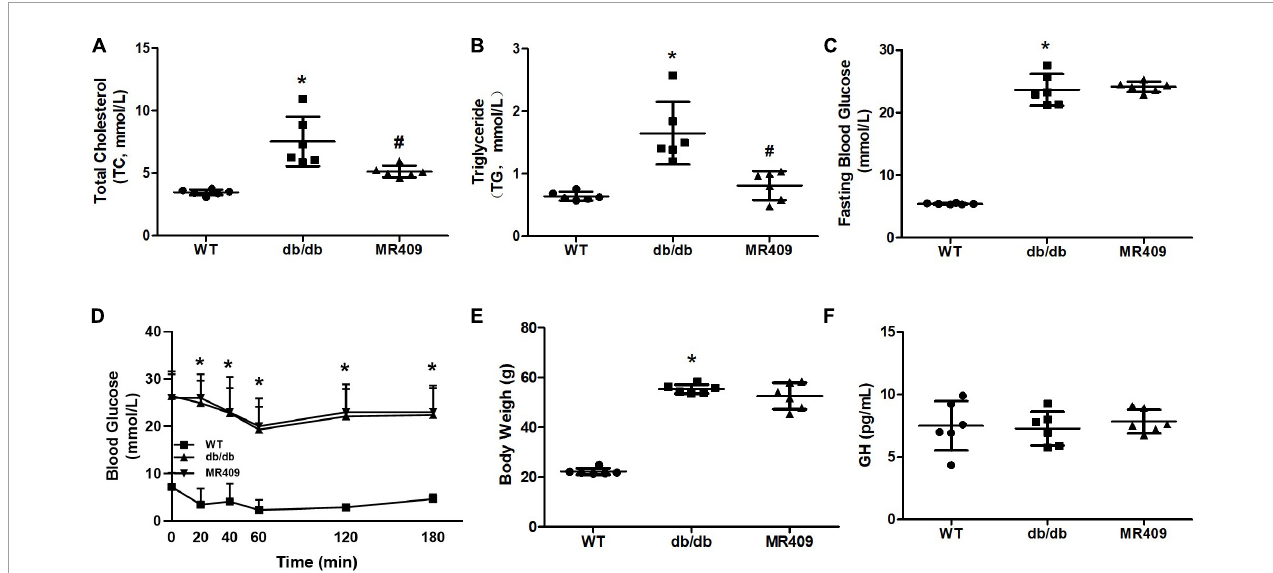
FIGURE1 Effects of MR409 on plasma levels of total cholesterol (Ch, A ) and total triglyceride (TG, B ), fasting blood glucose (C) , insulin tolerance (D) , body weight (E) and serum level of growth hormone (GH, F ) in diabetic db/db mice. Data is expressed mean ± SD, n = 6, * p < 0.05 diabetic mice vs. WT mice, # p < 0.05 MR409 treated mice vs. diabetic